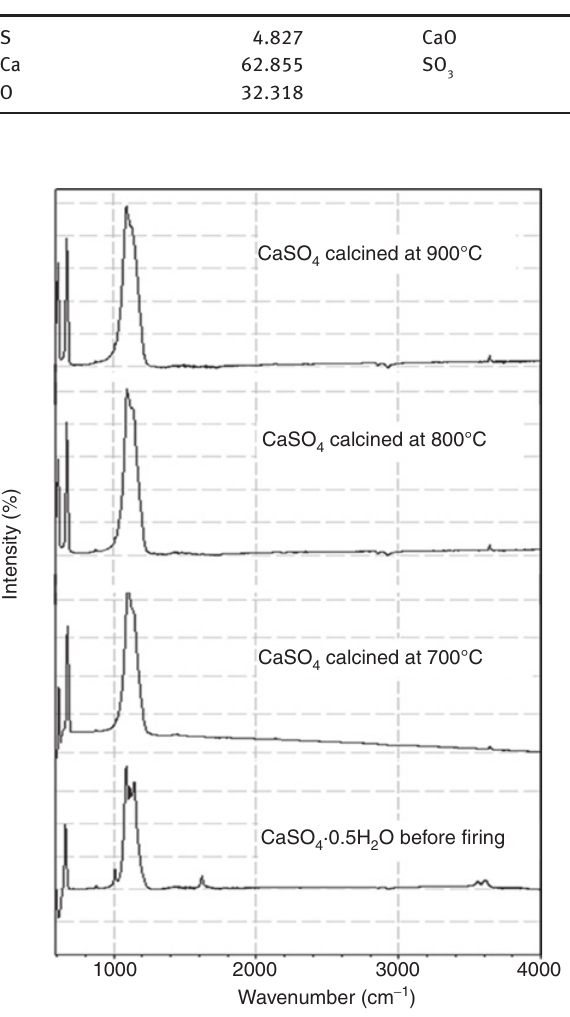
Figure 3: FTIR spectra of the obtained calcium sulfate samples as prepared from the chemical reaction between the raw duck eggshell and sulfuric acid (H SO ) before and after calcinations at 700, 800 2 4 and 900 ° C, for 2 h, respectively.